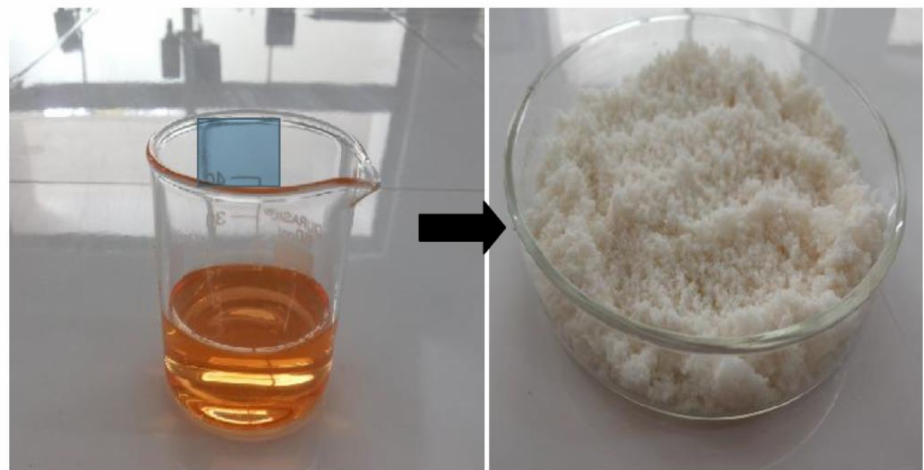
Figure 8. Photographs showing the liquid SNEDDS and solid SNEDDS prepared by solid carrier adsorption